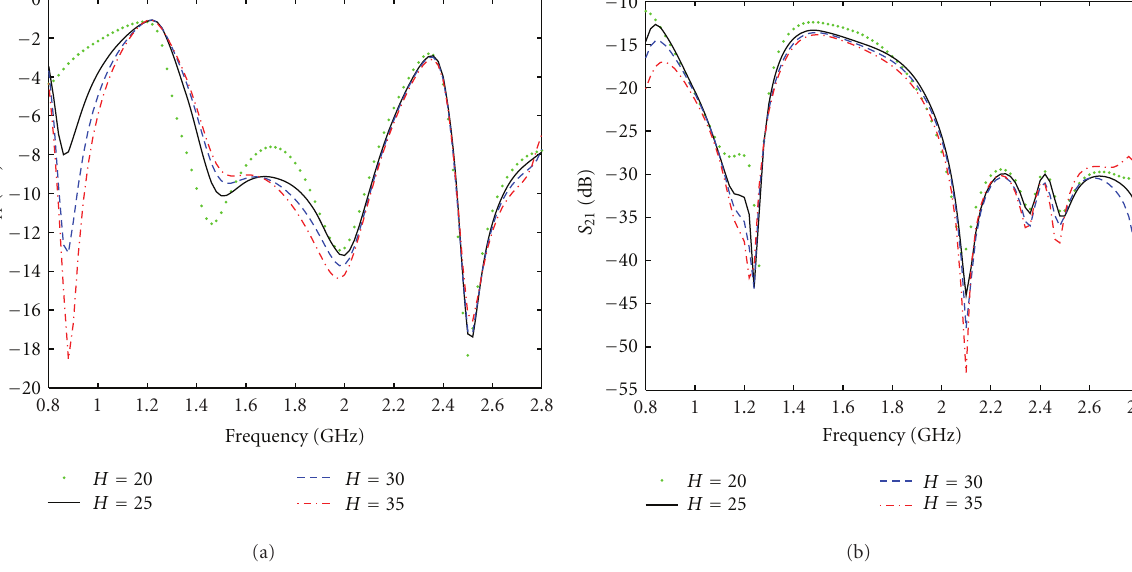
between the two monopole antennas is strong enough for mobile